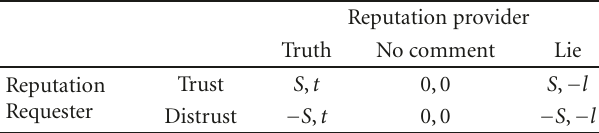
Table 2: Payo ff table of recommendation game. Reputation provider Truth No comment